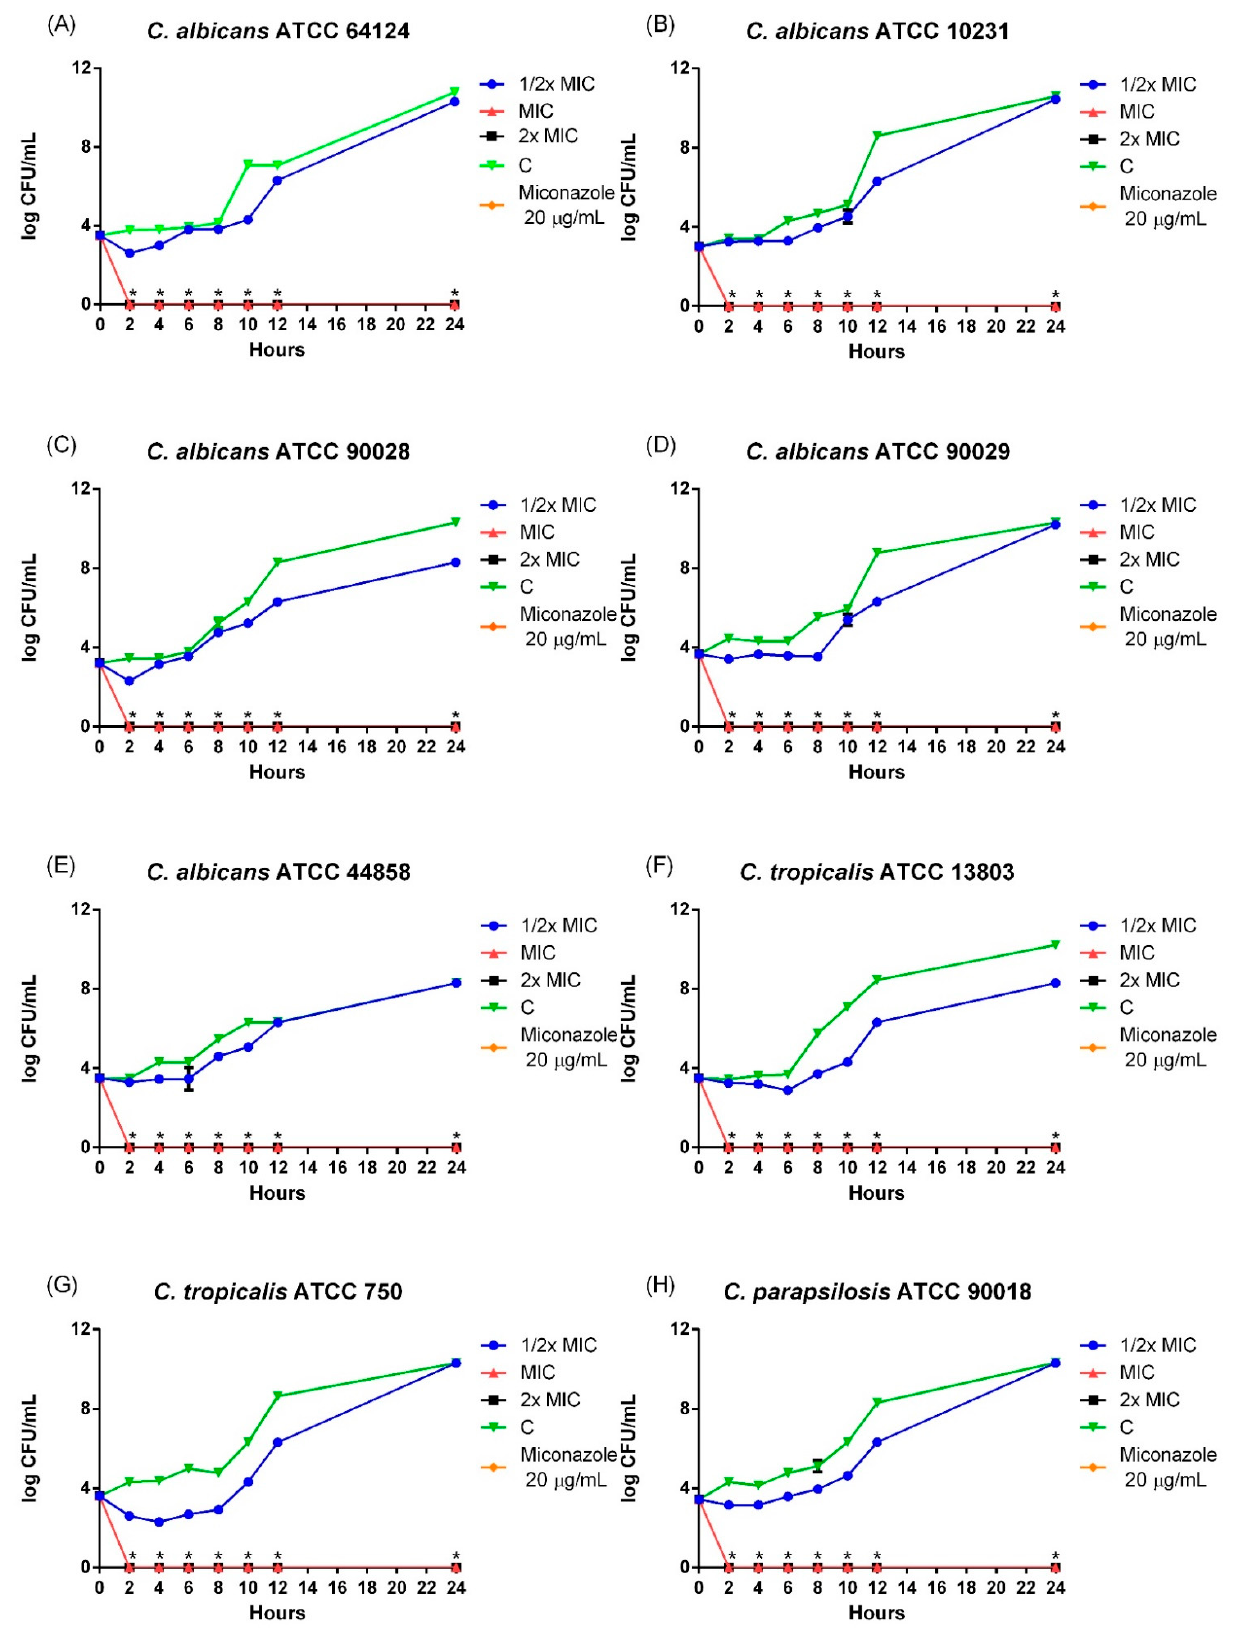
Figure 1. Effect of the time of exposure on the minimum inhibitory concentration of LaEO on the viability of Candida strains, determined by the microdilution technique in culture broth and